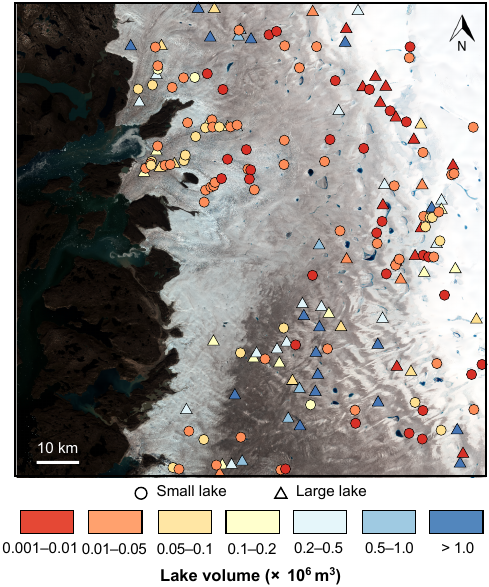
Figure 9. Lake water volumes measured using the physically based technique on the days prior to rapid drainage, categorised into small ( < 0 . 125km 2 in area; circles) and large lakes ( ≥ 0 . 125km 2 in area; triangles). Each point shown is also assumed to represent the loca- tion at which a moulin is opened by hydrofracture during rapid lake drainage, which then remains open for the remainder of the melt season. The panel coverage and background are the same as that in Fig. 1.